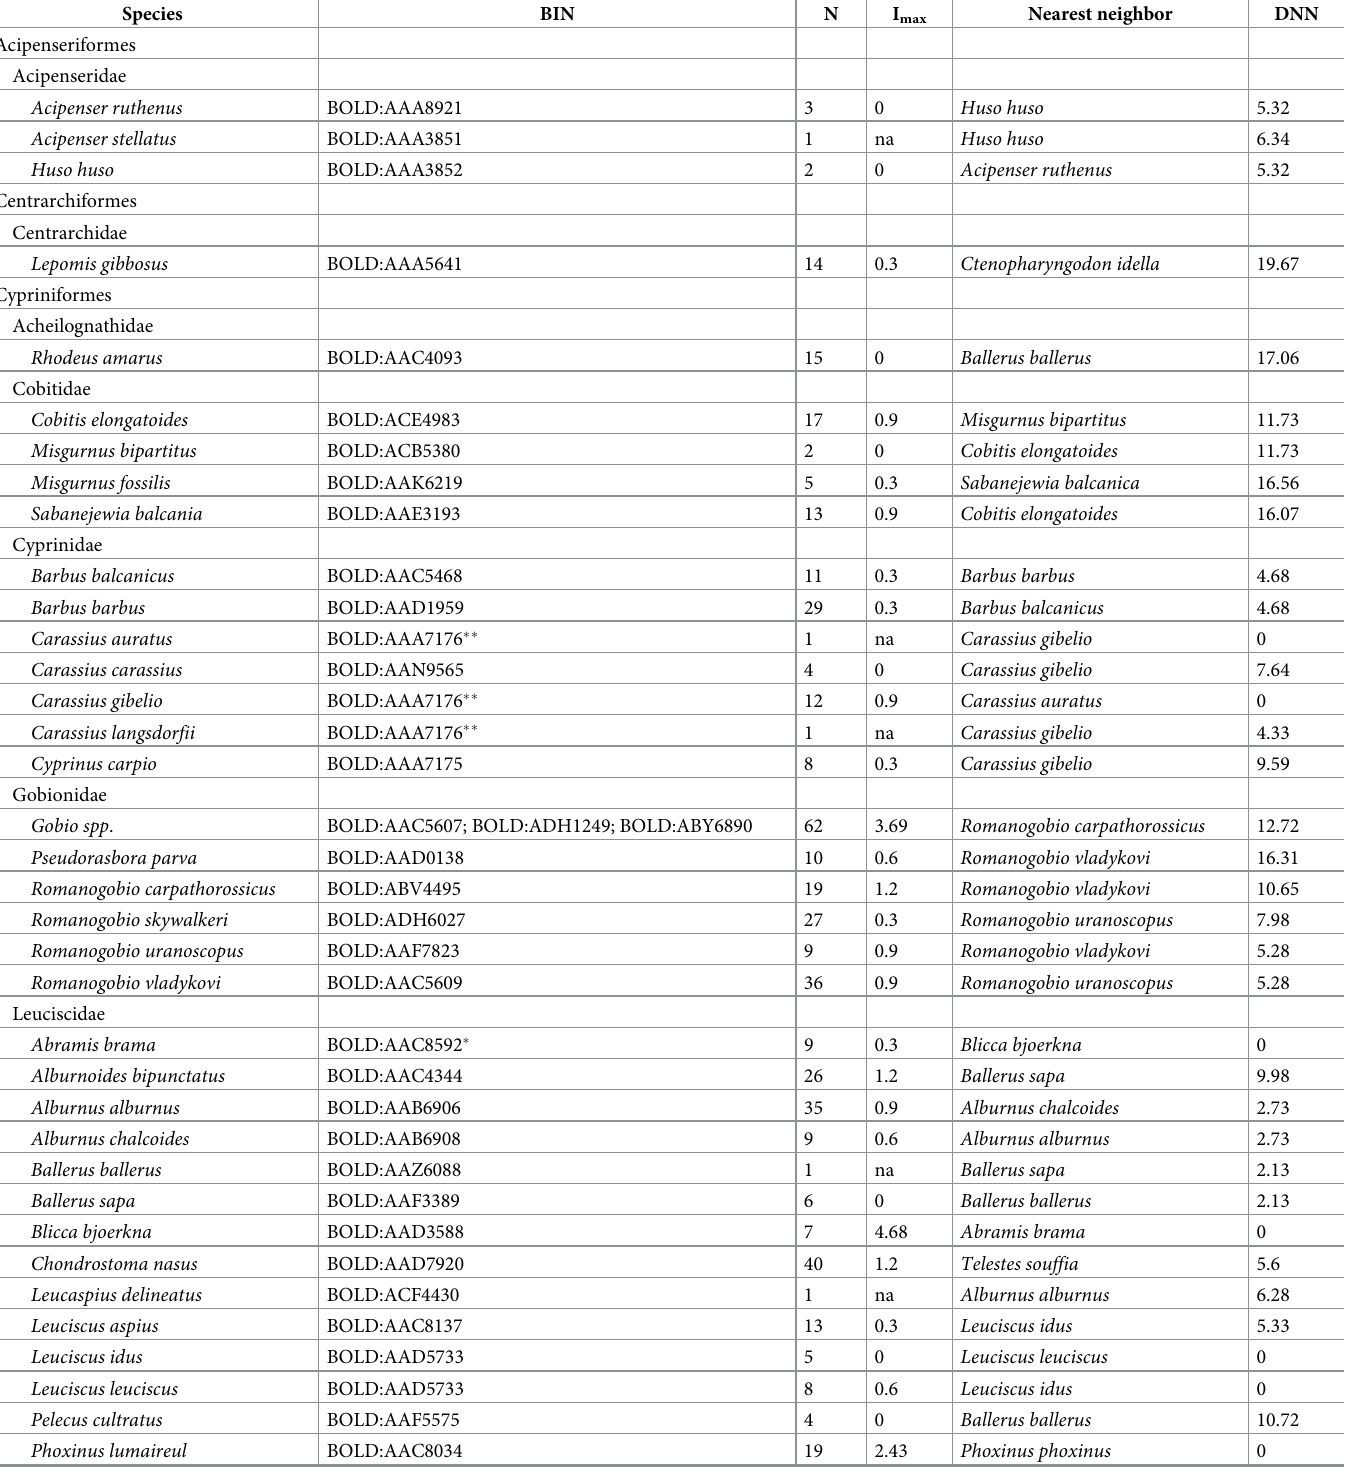
Table 1. K2P distances (in %) of COI sequences within and between Austrian fish species.